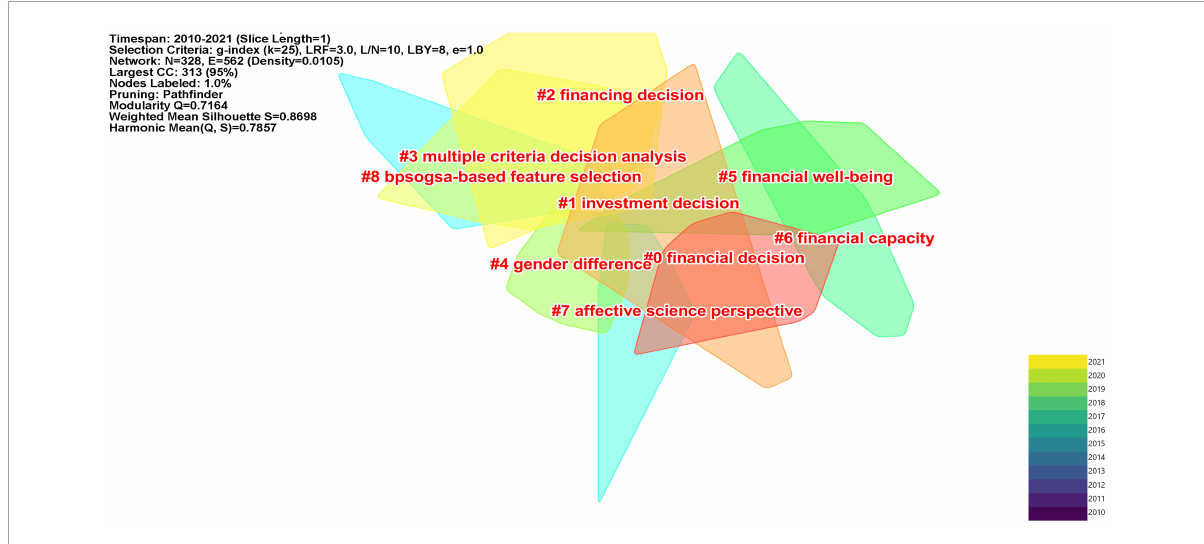
FIGURE6 Co-citation clusters (2010–2021).